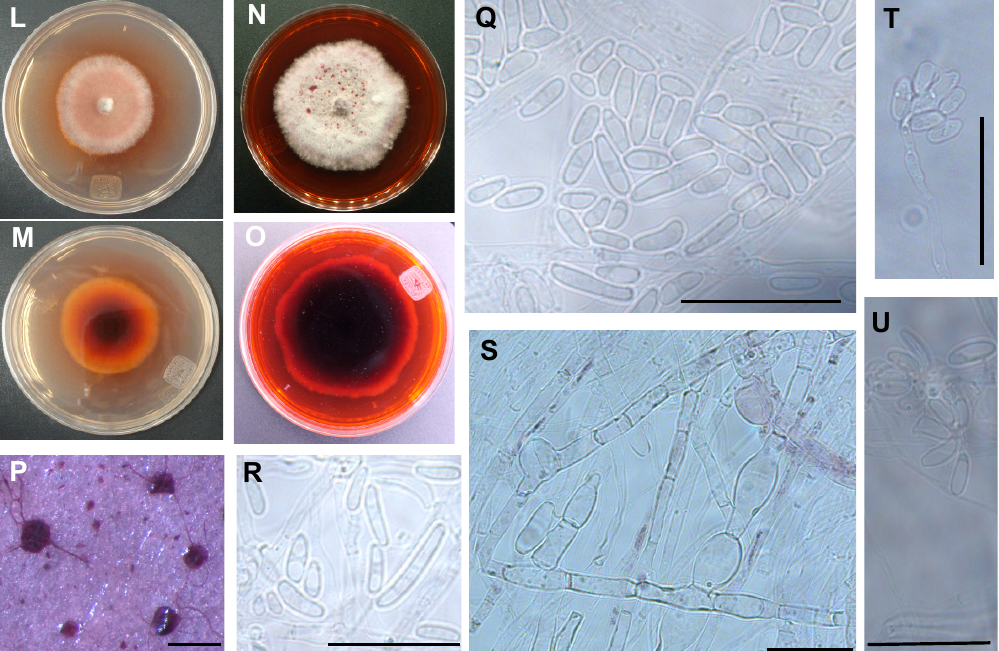
Figure 2. Morphological characteristics of Fusarium sp. INECOL_BM-04 and Fusarium sp. INECOL BM-06 isolated from X. morigerus. Colony morphology in PDA at 7 and 14 days of incubation of Fusarium sp. INECOL_BM-04: ( A , C ) colony surface; ( B , D ) colony undersurface, and Fusarium sp. INECOL_BM-06; ( L , N ) colony surface; ( M , O ) colony undersurface. Microscopic characters of Fusarium sp. INECOL_BM-04: conidia ( E – G ), chlamydospores ( J , K ), and aerial conidiophores ( H , I ) in SNA or CLA; and Fusarium sp. INECOL_BM-06: sporodochia in PDA ( P ), conidia ( Q , R ), chlamydospores ( S ) and aerial conidiophores ( T , U ) in SNA or CLA. Photographs were taken at 10 dpi. Scale bar = 25 µm; scale bar in p = 1 mm.